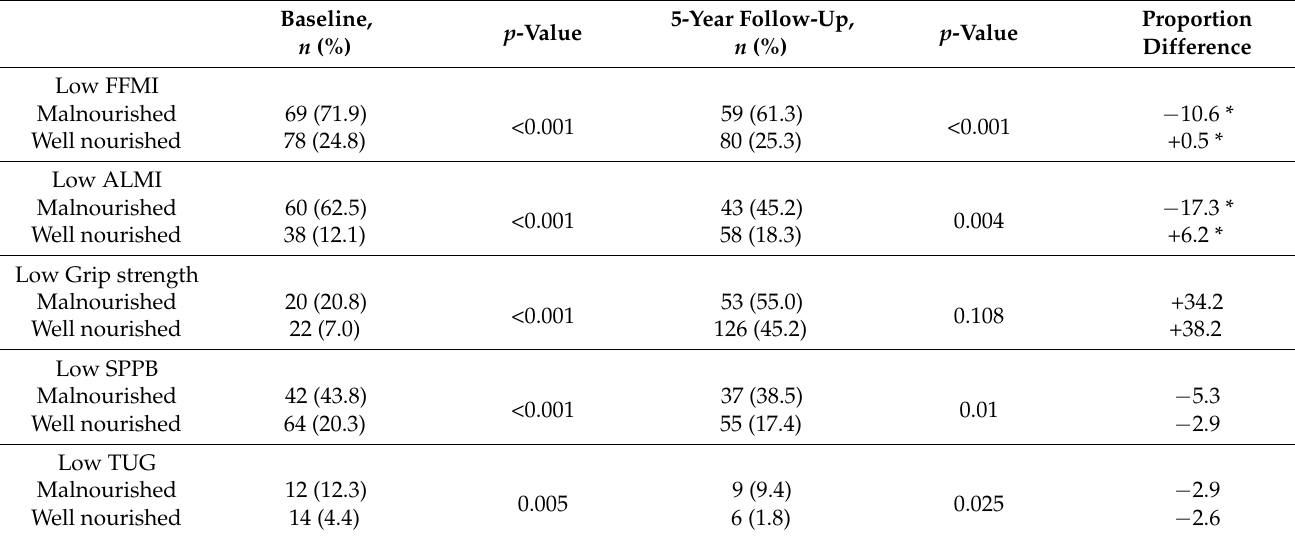
Table 5. Low muscle mass, muscle strength and physical performance at T0 and T5 and the change in the proportion of individuals with low muscle parameters between T0 and T5 compared according to nutritional status ( n =